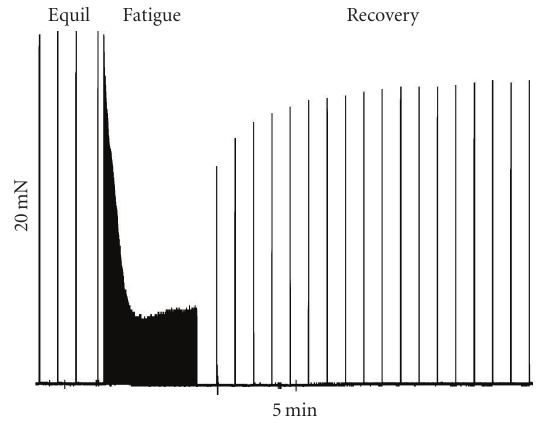
Figure 1: Original raw digital tracing of a control DPH muscle strip showing our intact contractility protocol. This intact contractility record shows the last 4 minutes of equilibration (Equil), followed by the fatiguing stimulation period (Fatigue, 5 minutes) and by the recovery period. During Equil and Recovery, the muscle strip was stimulated with tetanic contractions every minute, while during the fatigue period, the muscles were stimulated every second. Calibration bars for this specific experiment are shown. The horizontal bar denotes time in minutes and the vertical bar the relative force in mN produced by the